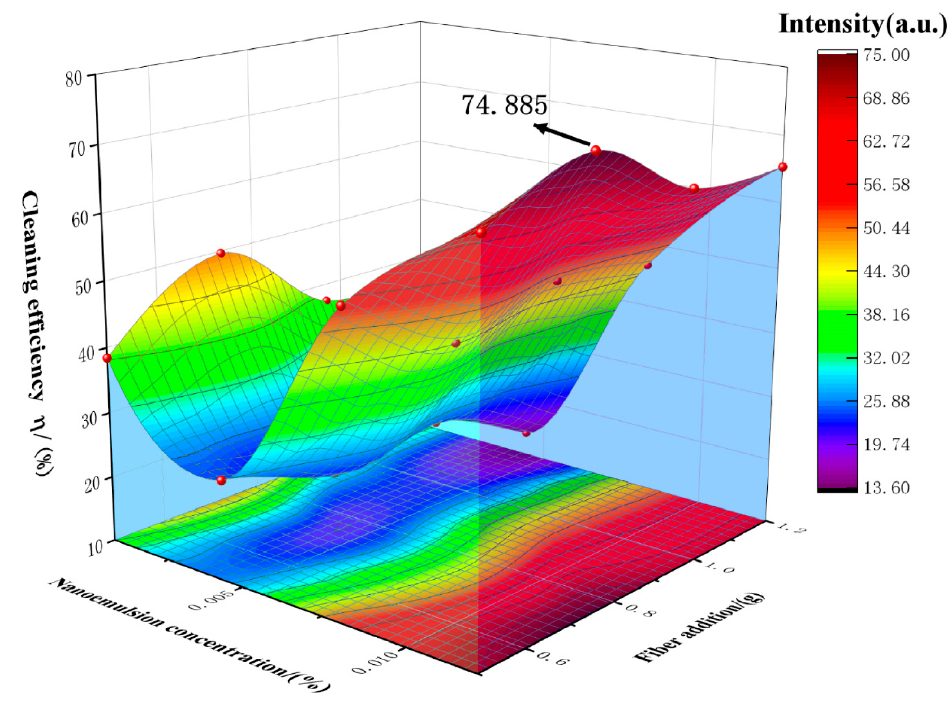
Figure 10. Nano-cleaning fluid cleaning Figure 10. Nano ‐ cleaning fluid cleaning efficiency.